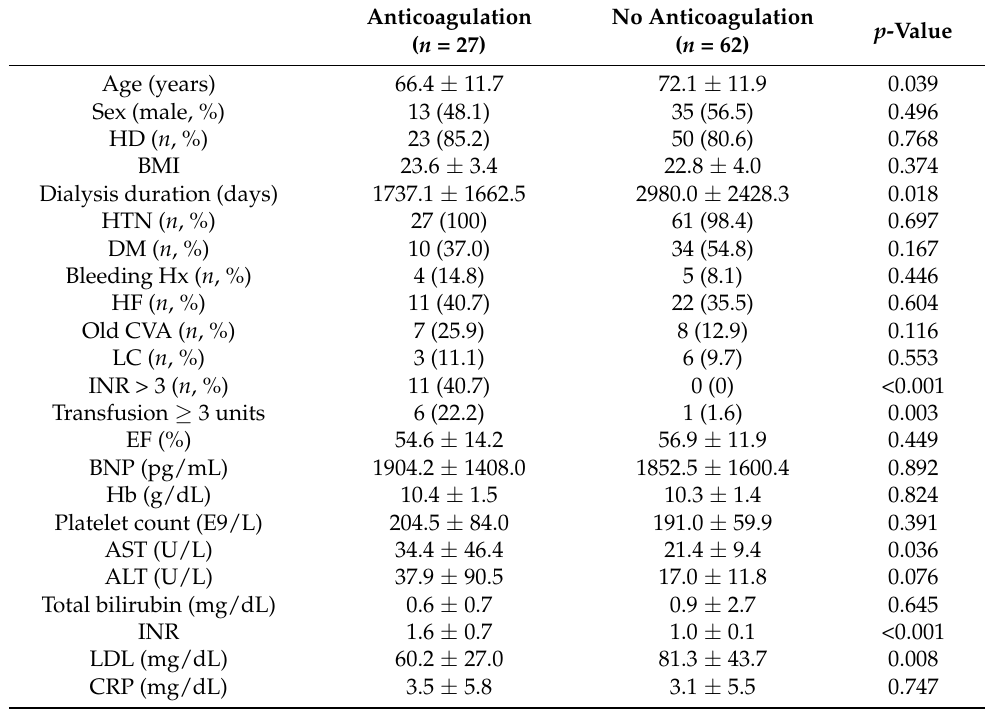
Table 1. Baseline characteristics of anticoagulation and no anticoagulation